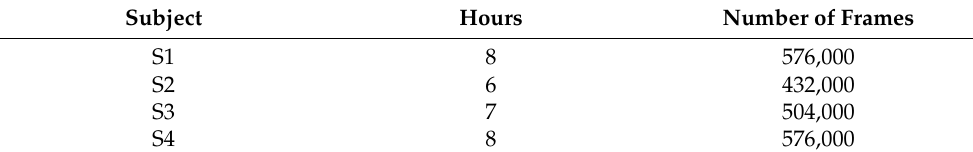
Table 5. The iSP real-life dataset summary.